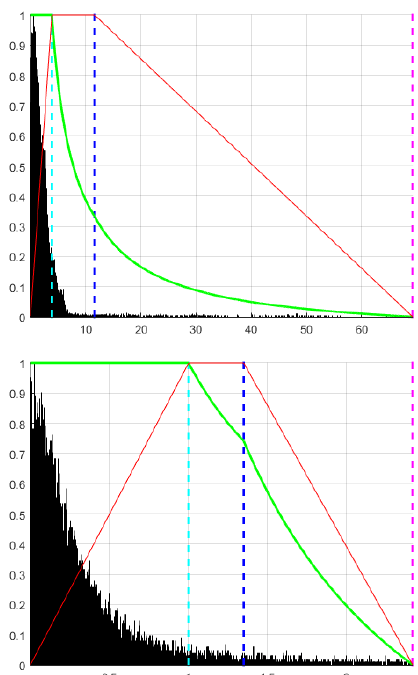
Figure 2. Illustration of residual weighting using Hampel estimator. Top: first iteration, bottom: after first outlier removal. The histogram of residuals (black) is overlaid with the weighting function (solid green) and corresponding influence function (solid red). The vertical dashed lines indicate the barriers 𝑎 , 𝑏 and 𝑐 (from left to right). Histogram and influence function are scaled for